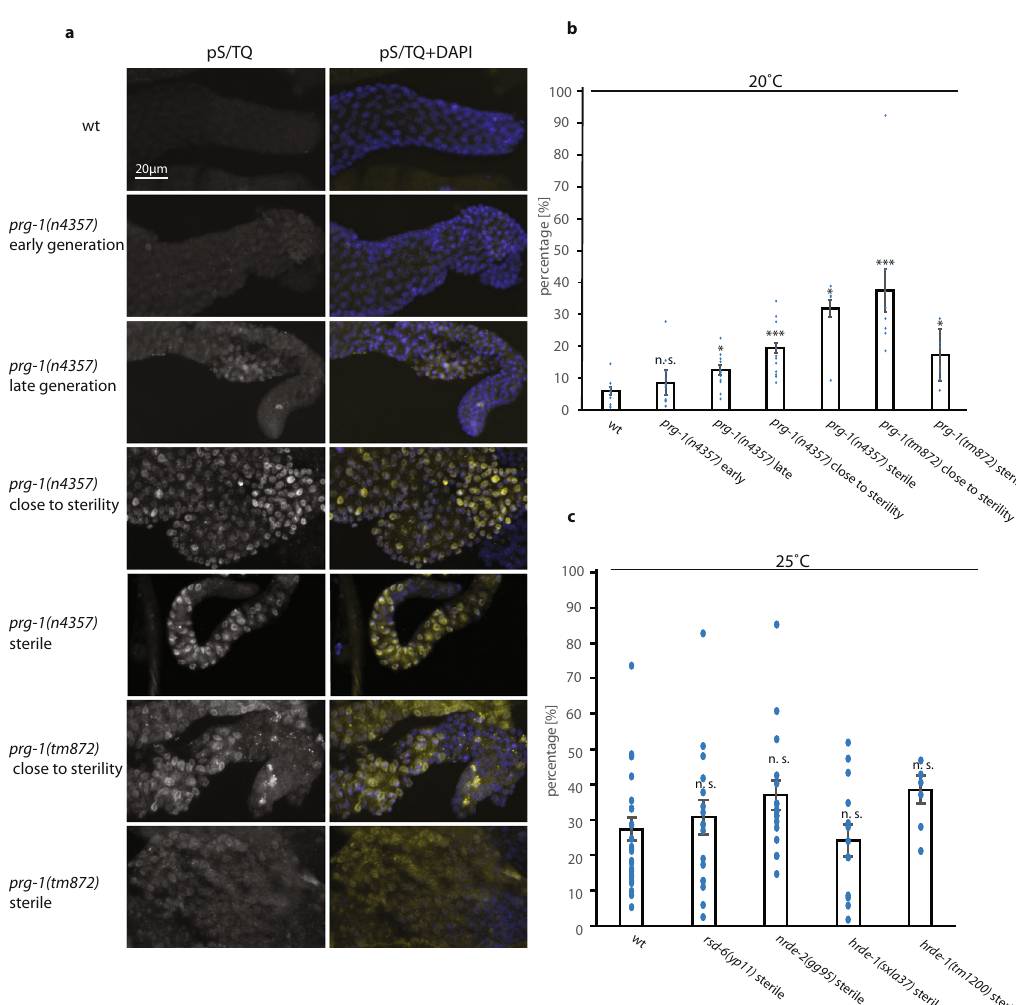
Fig. 1 DNA damage response is variable in Piwi pathway genome silencing mutants prior to and at sterility. a Staining of pS/TQ in wild type, prg-1 (n4357), and prg-1(tm876) mutants. pS/TQ (gray and yellow) and DAPI (blue). pS/TQ staining in wild type, prg-1(n4357), and prg-1(tm876) mutants was repeated three times with similar results. Representative images are shown. b Quanti fi cation of pS/TQ staining in 20 °C wild-type and prg-1 mutants at different levels of fertility (wt n = 14; prg-1(n4357) : early generation n = 14, late generation n = 12, close to sterility n = 11, sterile n = 4; prg-1(tm872) : close to sterility n = 8, sterile n = 8. Error bars represent the standard error of the mean (SEM). p -Values were obtained by comparing sample groups in a two-sided Mann – Whitney U test with Bonferroni correction ( p >0.05 = n. s., p <0.05 = *, p = <0.01 = **, p = <0.001 = *** compared to wild type). c Quanti fi cation of pS/TQ staining in 25 °C wild-type and small RNA genomic silencing mutants at sterility; wt n = 25; rsd-6(yp11) n = 17; nrde-2(gg95) n = 17; hrde-1(sxla37) n = 13; hrde-1(tm1200) n = 6. Error bars represent the standard error of the mean (SEM). p -Values were obtained by comparing sample groups in a two-sided Mann – Whitney U test with Bonferroni correction ( p > 0.05 = n. s., p < 0.05 = *, p = < 0.01 = **, p = < 0.001 = *** compared to wild